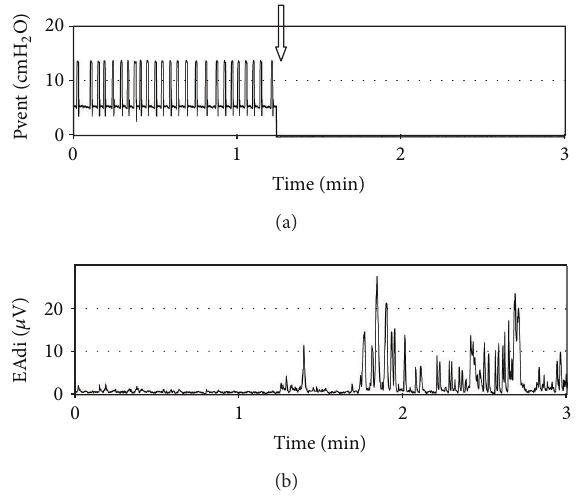
Figure 2: Evolution of ventilatory pressure (a) and electrical activity ofthediaphragm(b)surroundingextubation(arrow)ina2-year-old girl with meningitis. Note the very low diaphragm activity prior to extubation on low level of assisted ventilation (pressure support of 7cm H 2